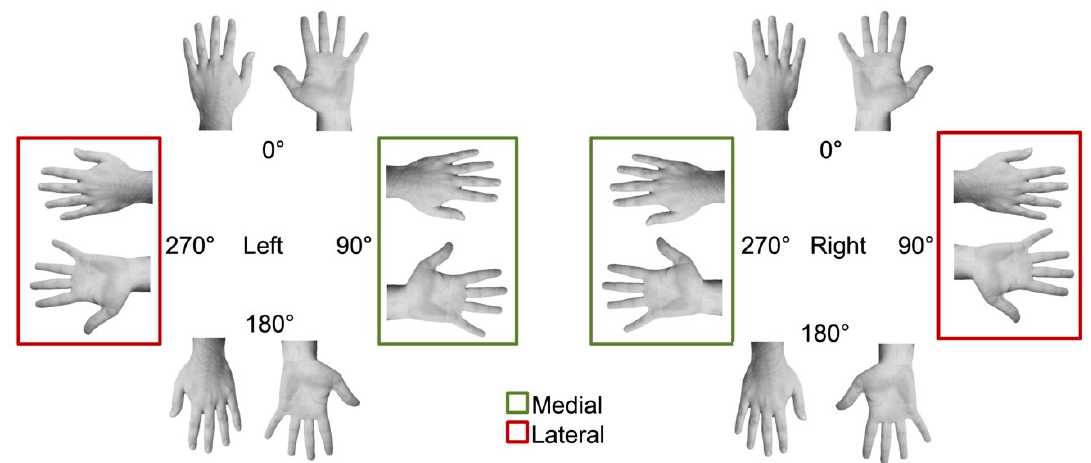
Figure 2. Examples of stimuli used in the hand laterality judgment. In particular, male hands viewed from the dorsum and palm are displayed. Hand stimuli taken into account to compute the biomechanical effect are highlighted: hand images showing medial (green square) versus lateral (red square) positions.